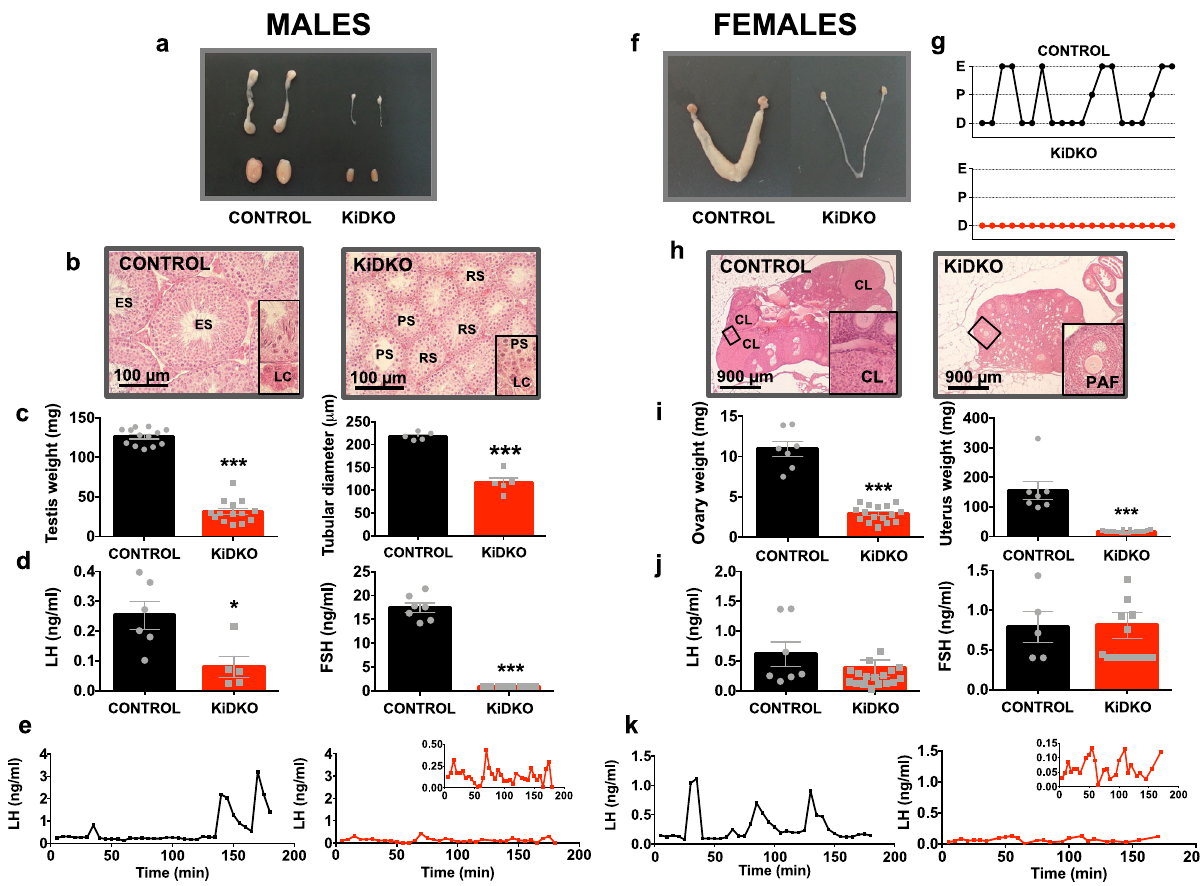
Fig. 1 | Profound hypogonadotropic hypogonadism in adult KiDKO mice. Representative images of the gonads (testes and ovaries) and sex organs (epi- didymis and uterus) for adult control and KiDKO mice of both sexes are pre- sented in ( a ; males) and ( f ; females). For the latter, individual pro fi les of ovarian cyclicity, monitored by vaginal cytology, are also shown in ( g ). In addition, representative histologicalsections of the testis ( b ) and ovary ( h ) are presented forcontrolandKiDKOmice.Controlmiceshowedcompletespermatogenesisin the lumen of seminiferous tubules, denoted by the presence abundant elon- gated spermatids (ES) and prominent Leydig cells (LC; inset) in the interstitium. In contrast, KO mice showed atrophicseminiferoustubuleswith spermatogenic arrestatthe primaryspermatocyte (PS)or round spermatid (RS)level, as well as poorly differentiated Leydig cells (LC; inset). In the case of the ovary, while control females showed cycling ovaries with abundant growing follicles and corpora lutea (CL), in KiDKO females, large antral follicles and corpora lutea